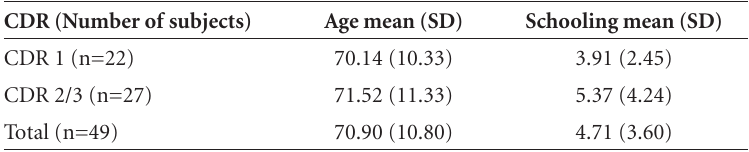
Table 1. Sociodemographic data.